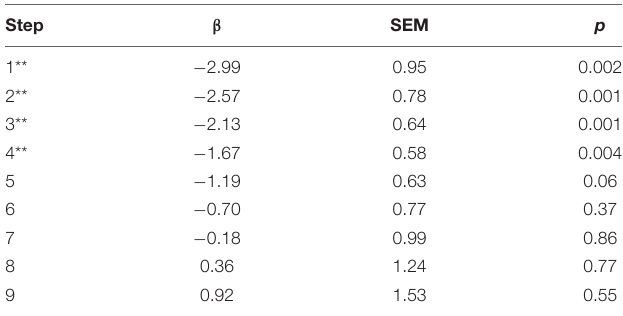
TABLE 3 | Coefficient, standard error of the mean, and level of significance of timepoint difference for skin conductance multi-level